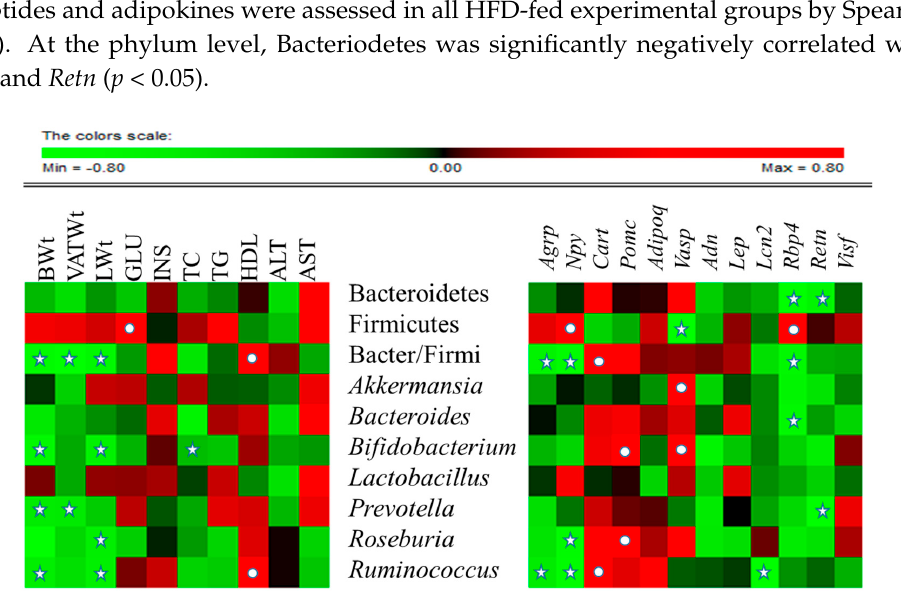
Figure 6. Correlation between gut microbial relative abundance and host metabolic parameters, neuropeptides and adipokines: Data of all experimental groups (except normal) were gathered and analyzed by SPSS software (17.0. version, Chicago, IL, USA) using Spearman’s rho calculated by Permut Matrix software (version 1.9.3 EN, Montpellier, France) for heatmap plots. As the colors scale shows, green color indicates a negative correlation, while red color denotes a positive correlation. The ★ symbol indicates statistically significant negative correlation ( p < 0.05) and • symbol indicated statistically significant positive correlation ( p < 0.05).